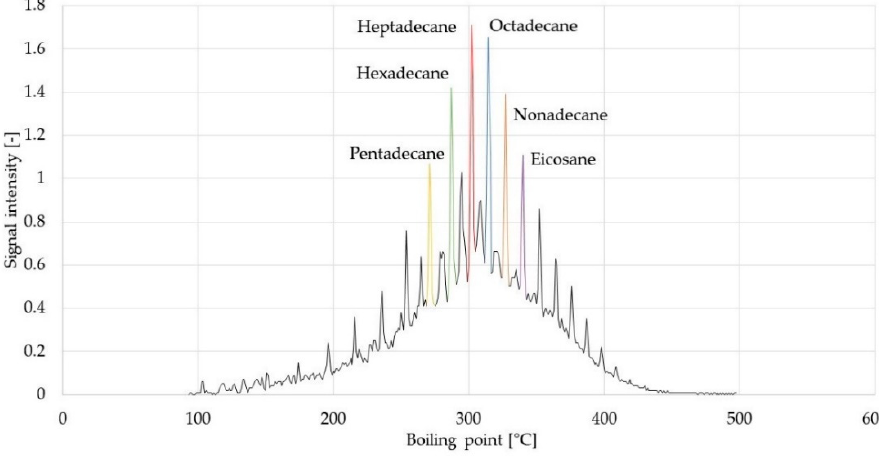
Figure 15. Selected alkanes in average sample after deactivation (second test).